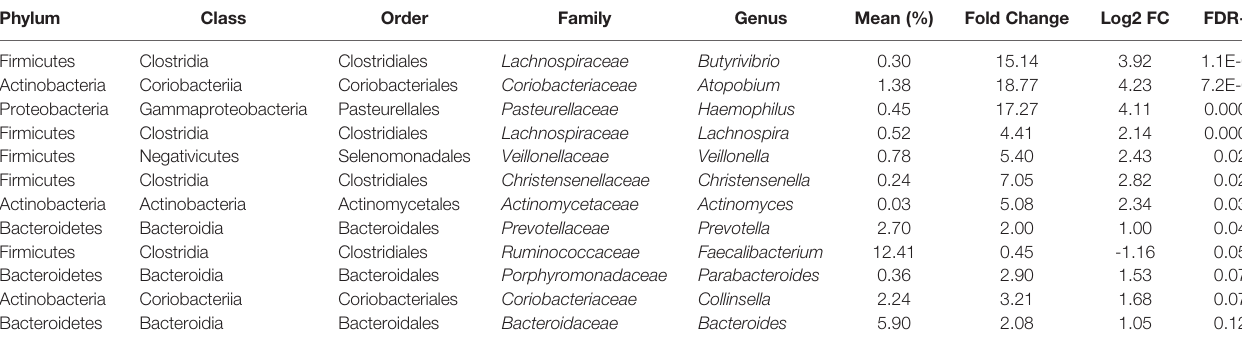
TABLE 2 | Bacterial genera that differed signi fi cantly between patients with APECED and controls.